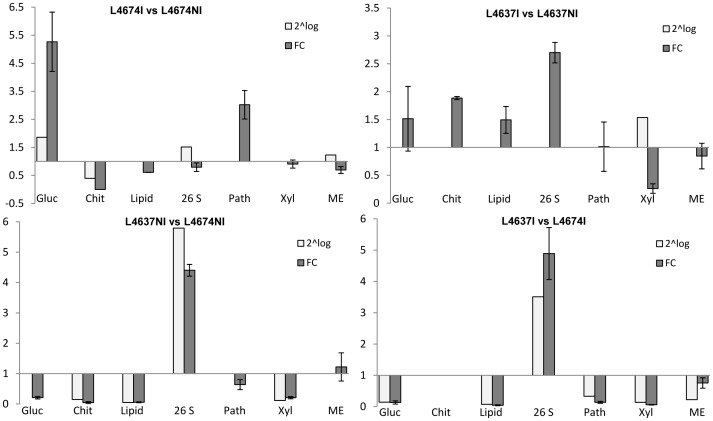
Gene expression analyses by qRT-PCR of seven selected genes.Gluc: glucanase, chit: chitinase, Lipid: Nonspecific lipid-transfer protein, 26S: 26S proteosome, Path: pathogen related protein, Xyl: xylanase inhibitor, ME: malic enzyme, FC: fold change gene expression, 2∧log: antilog2 (log2 of each comparison of microarrays data).Changes of Defense Genes in Silks.